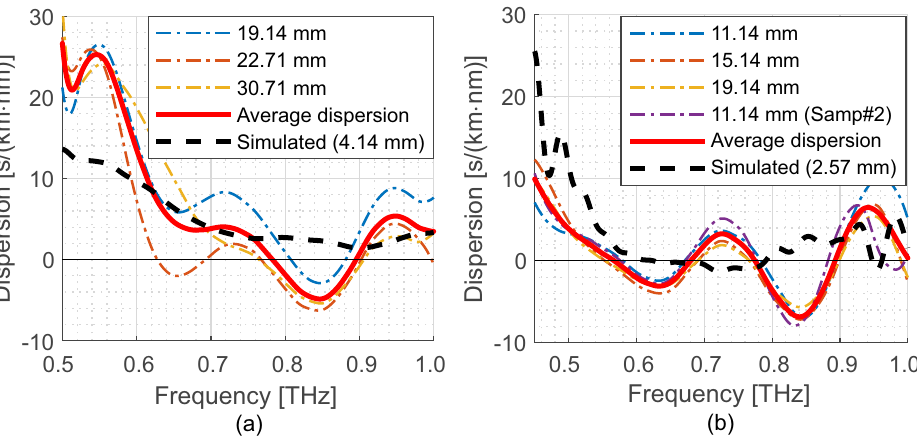
Figure 3. ( a , b ) show measured dispersion in waveguides of different l WG but same ROC , placed on quartz and HDPE substrate, respectively. Total and averaged dispersion of 3 waveguides with bend radius of 2 mm are compared with a simulated waveguide of same bend radius in ( a ). All waveguides shown in ( b ), along with the simulated one have a bend radius of 1 mm. The dispersion values are averaged over 30 GHz in order to reduce the influence of standing